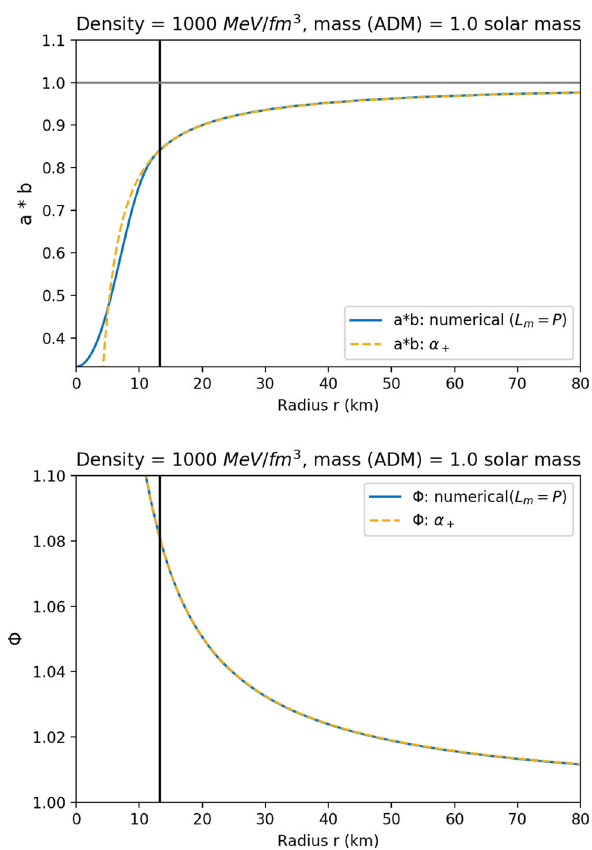
Fig. 4 Comparison of the product of the metric components and the scalar field between the analytical solution α + and the numerical solu- tionfor L m = P ,and ρ 0 = 1000 MeV / f m 3